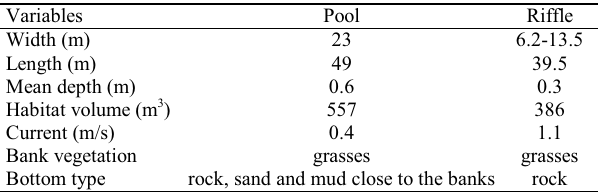
Table 1. Physiographical Variables for Each Mesohabitat (pool and riffle) Studied in the Ribeirão Santa